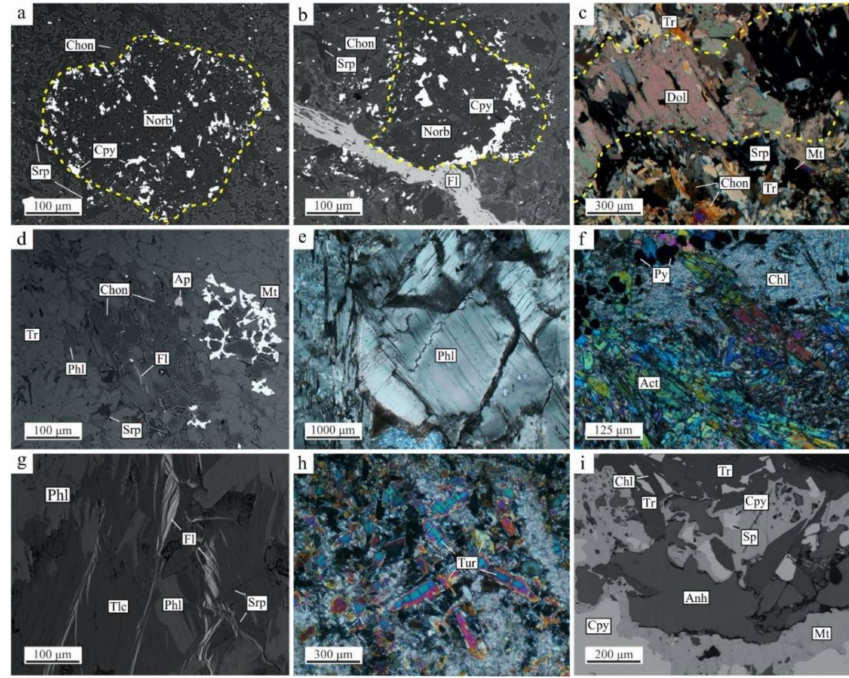
Figure 9. Photomicrographs and backscattered electron micrographs of typical skarn mineral assemblages of the Kultuma deposit. ( a ) retrograde chondrodite–norbergite skarn; ( b ) fluorite veinlet in chondrodite–norbergite skarn; ( c ) dolomite veinlet in retrograde tremolite–chondrodite skarn; ( d ) retrograde tremolite–chondrodite skarn; ( e ) retrograde phlogopite skarn; ( f ) retrograde actinolite skarn with chlorite; ( g ) magnetite and chalcopyrite in anhydrite–chlorite (potassic) al- teration overprinting tremolite skarn; ( h ) tourmaline in skarn-altered dolomite (propylitic alter- ation); ( i ) fluorite veinlet in scaly talc (hydrosilicate (propylitic) alteration tremolite–chondrodite